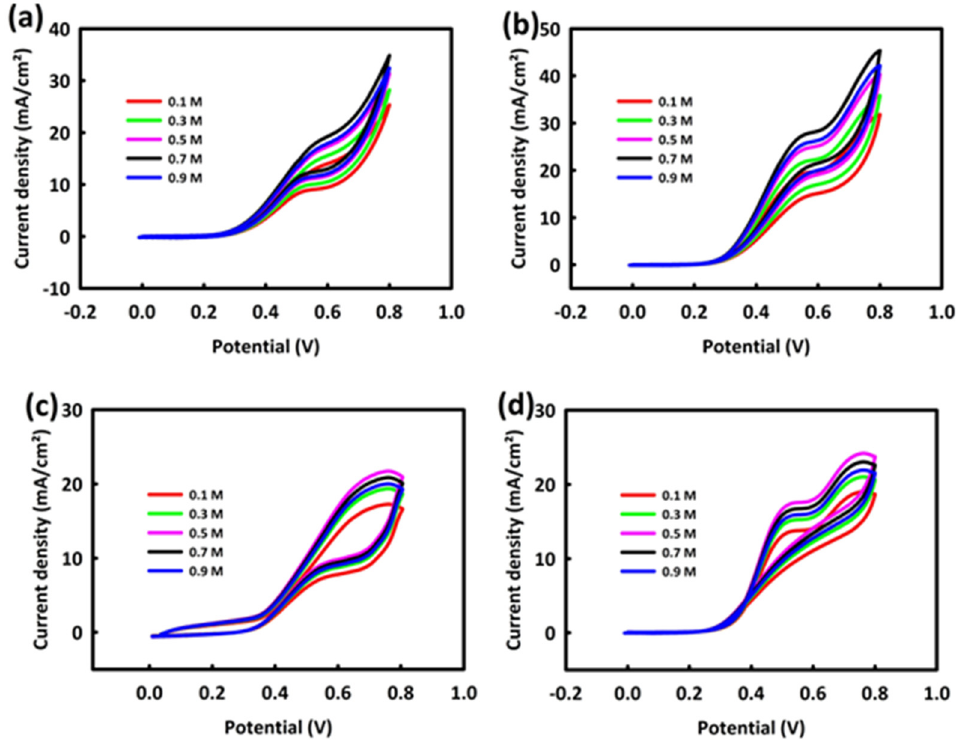
Figure 4. CV from ZrO 2 /NiO ( a ) and ZrO 2 /NiO/rGO ( b ) in 0.5 M KOH/different concentrations of methanol. CV from ZrO 2 /NiO ( c ) and ZrO 2 /NiO/rGO ( d ) in 0.5 M KOH/different concentrations of ethanol.